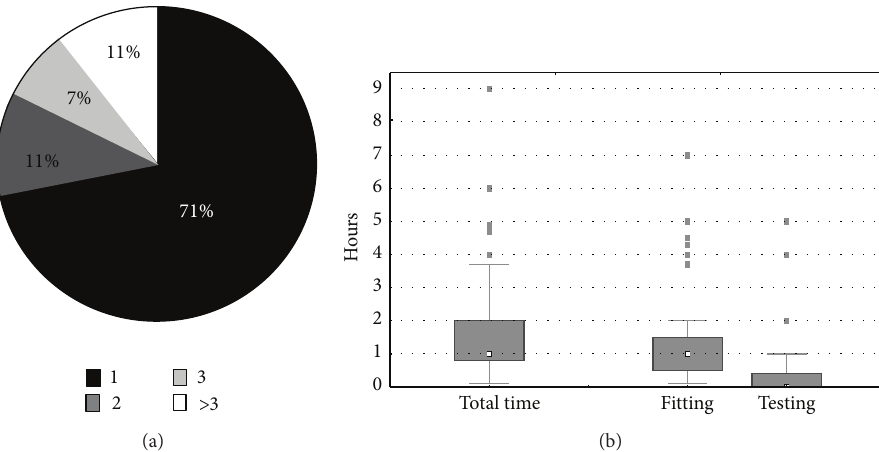
Figure 2: Time analysis of the switch-on session, showing the number of sessions at daily intervals which are considered to constitute the switch-on procedure (pie chart at the left) and the time spent at the switch-on session (box and whisker plot at the right), both the total time and its breakdown into time spent at fitting and at testing. Time for counseling has not been enquired in this study. See caption of Figure 1 to interpret the box and whisker